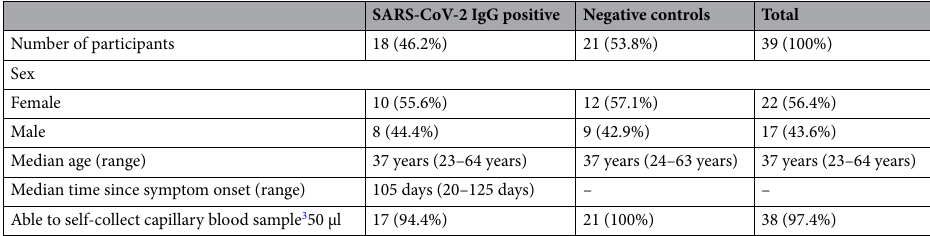
Table 1. Participant demographics. Data is N (%) or median (range).